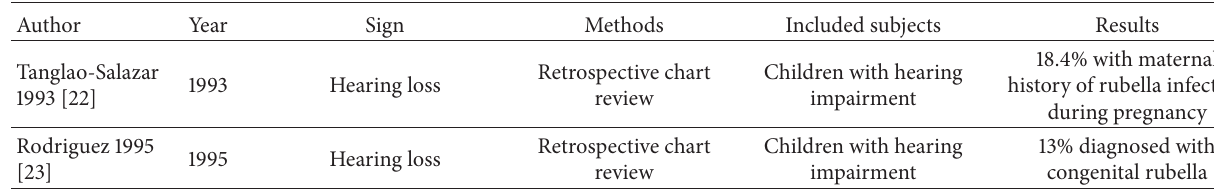
Table 2: Unpublished studies ( 𝑛 = 4 ) on congenital rubella syndrome.